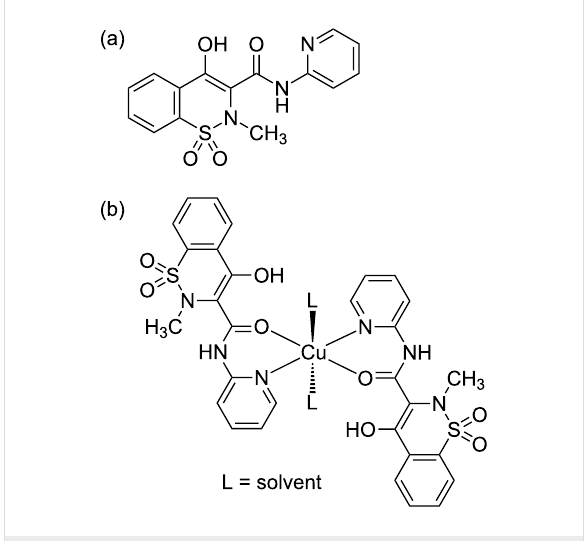
Figure 1: Structure of (a) piroxicam molecule and (b) Cu(II)–piroxicam